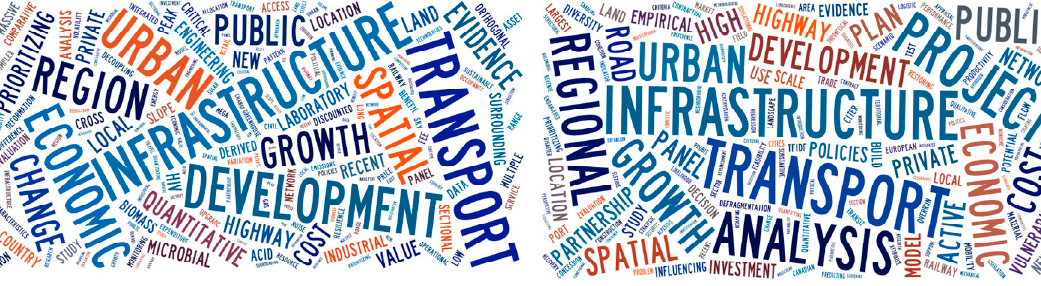
Figure 12. Word cloud distribution of co-citation cluster results. (Tool: Tagxedo (www.tagxedo.com). Data source: Labels of the top 62 clusters, narrative summary report of the co-citation network.)